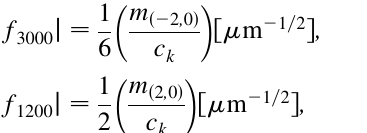
FIG. 9. (Color) Amplitude of the generating function term f versus longitudinal position from experiment and tracking model for the baseline machine at 26 GeV. The blue line is used to connect the experimental points.